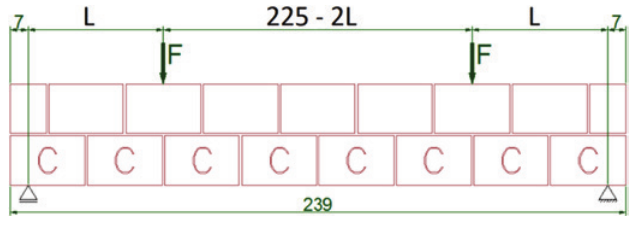
Loading (Type 1: L = 52,5 cm; Type 2: L = 82,5 cm;